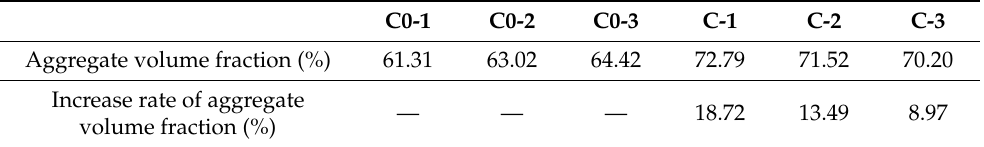
Table 9. Aggregate volume fraction in concrete.